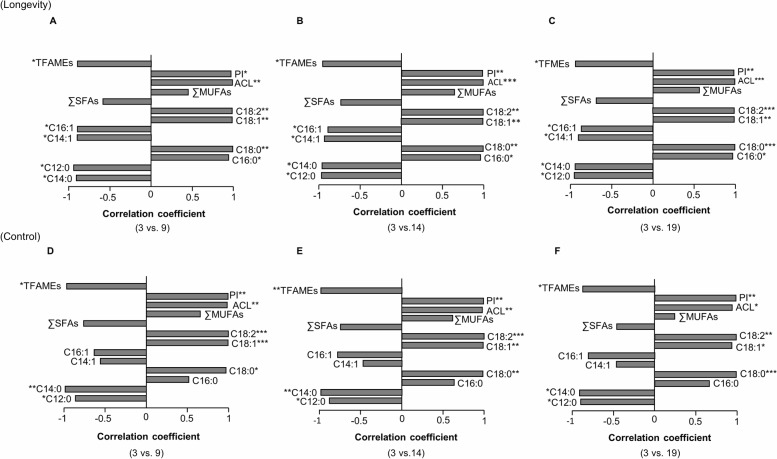
PCA loading plots of the age-associated effects on patterns of variation in neutral lipid fatty acids and related (un)saturation indices.Longevity-selected (A-C) and control lines (D-F) are shown separately. In both selection regimes, the fatty acid profiles of individuals at 3 days of age are significantly different from the profiles of other age groups (3 vs. 9: A, D; 3 vs. 14: B, E; 3 vs. 19: C, F). *P < 0.05, **P < 0.001, ***P < 0.0001.